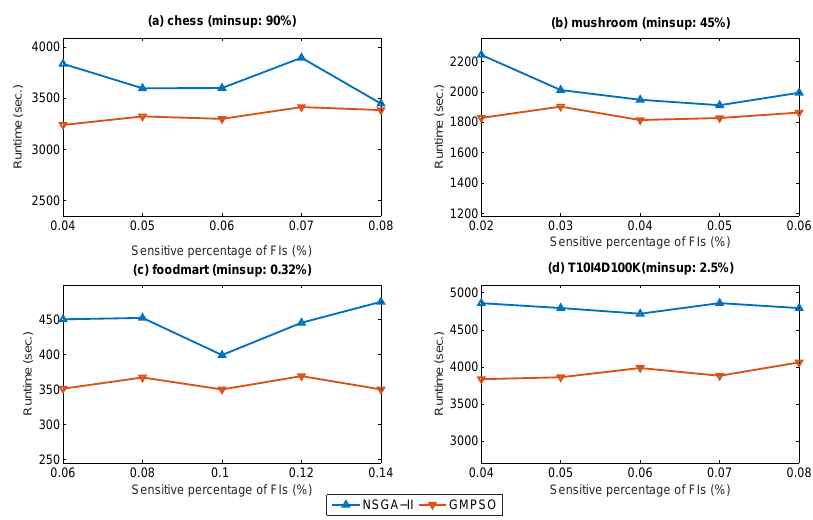
Figure 3. Runtime under varied percentages of sensitivity.